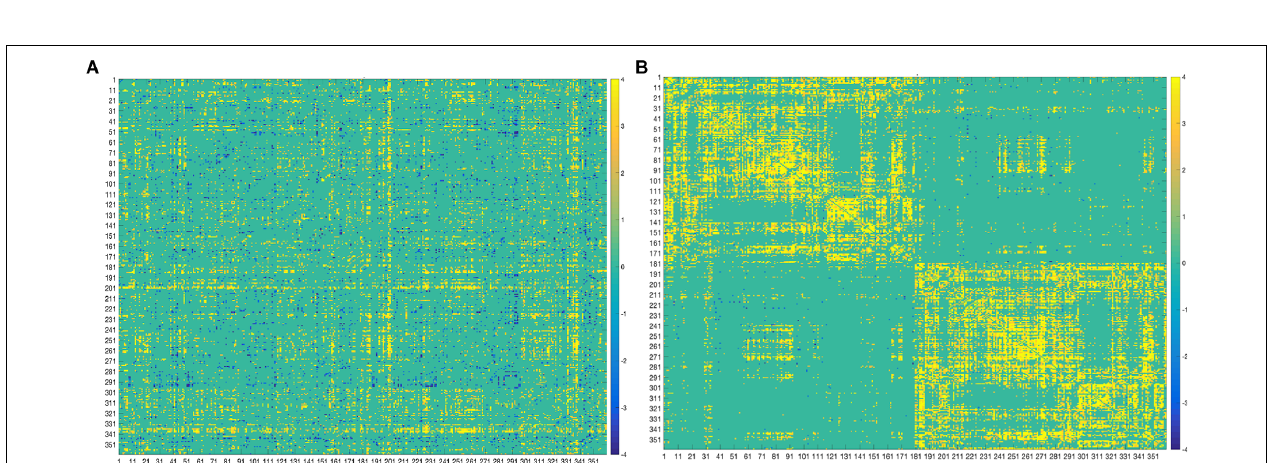
FIGURE 4 | Bootstrap connectivity weights for FC (A) and SC (B) change. The first 180 regions pertain to the left hemisphere and the next 180 (i.e., 181–360) to the right hemisphere (i.e., homologs). Their full description can be found in Table 1 in Supplementary Neuroanatomical Results in Glasser et al., 2017. The color bar refers to the bootstrap ratios. Connections with positive bootstrap ratios are positively associated with the FC or SC—cognition correlation, and negative bootstrap ratios are negatively associated with the FC or SC—cognition correlation.